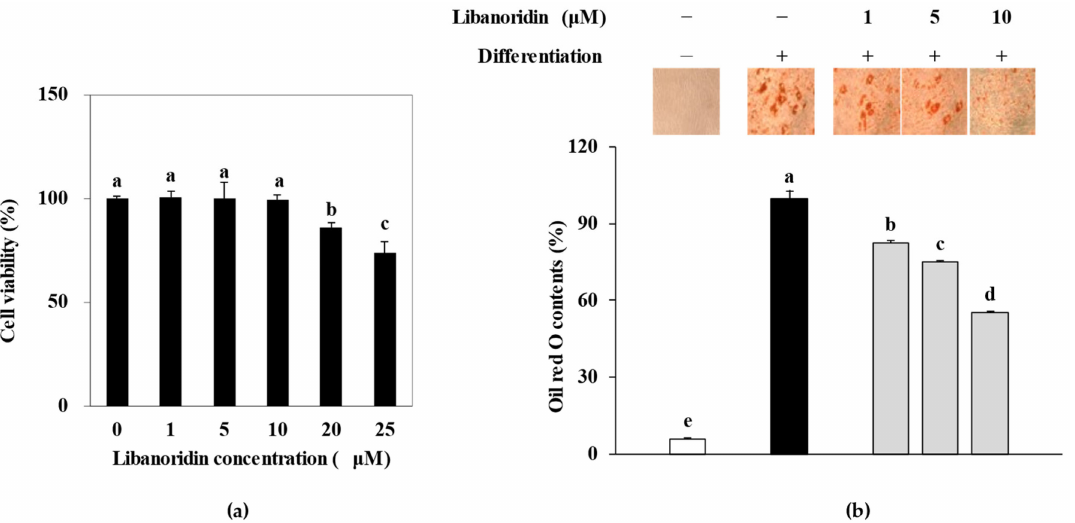
Figure 1. Effect of libanoridin on viability and lipid accumulation in hBM-MSCs. ( a ) Effect of libanoridin on the viability of non-differentiated hBM-MSCs. Cells were treated with libanoridin for 72 h. Cell viability is given as a relative percentage of the untreated (0 µ M) group. ( b ) Effect of libanoridin on the amount of accumulated intracellular lipid droplets. Droplets were stained by Oil Red O at day 12 of differentiation, and the Oil Red O stain retained by the cells was given as a relative percentage of the differentiated untreated group. Values are means ± SD ( n = 3). a–e Bars with identical letters indicate no statistical significance ( p < 0.05), while different letters indicate